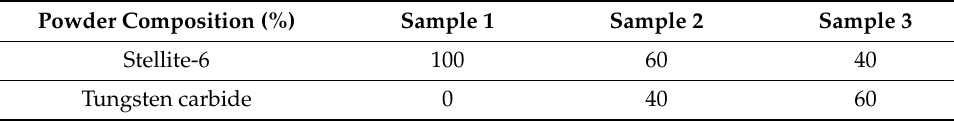
Table 4. Data of deposited powder on TC21